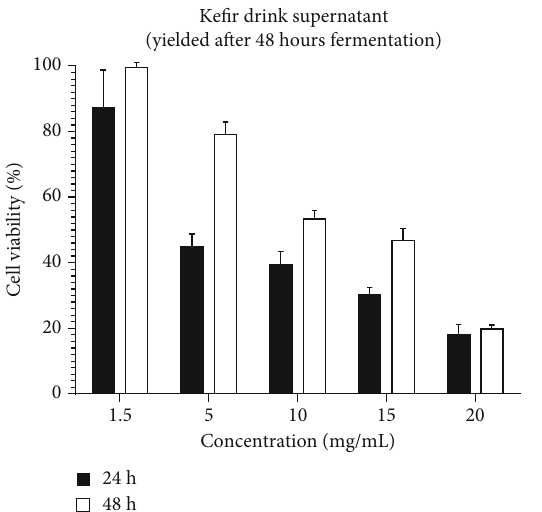
Figure 5: E ff ect sedimentation of cell lysate on U87 cell viability after 24 and 48 hours ( P value ≤